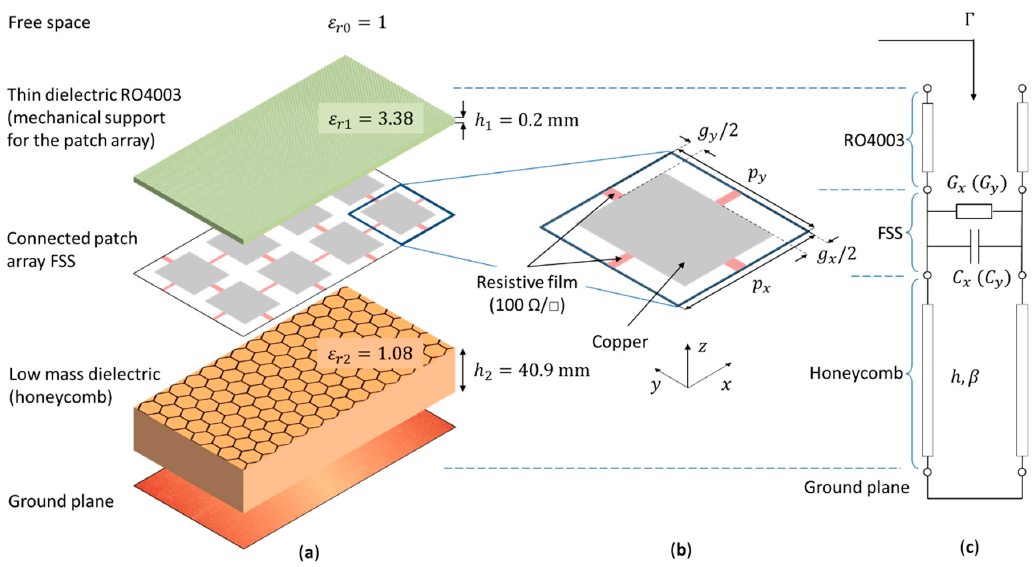
Figure 2. Geometry of the absorber ( a ) and of the rectangular unit cell of the frequency selective surface (FSS) ( b ). Dimensions along x and y directions are dedicated to TE and TM polarizations respectively. ( c ) Equivalent circuit valid for each polarization.